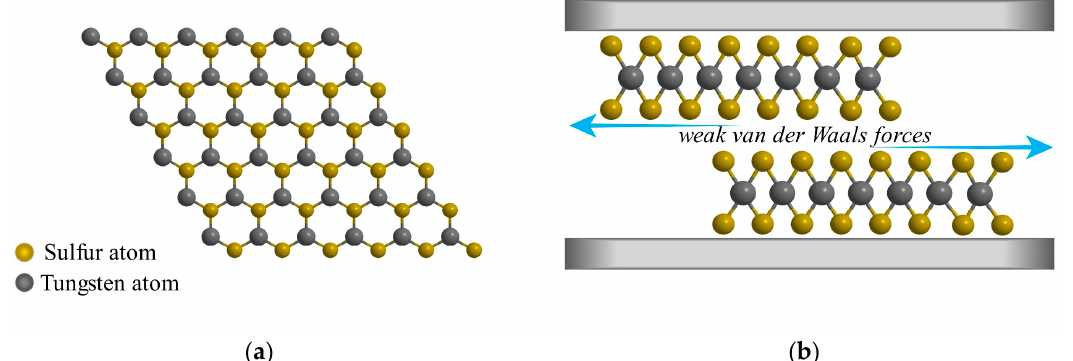
Figure 1. ( a ) Hexagonal structure of WS 2 (top view); ( b ) The relative sliding between two single layers of WS 2 (slide